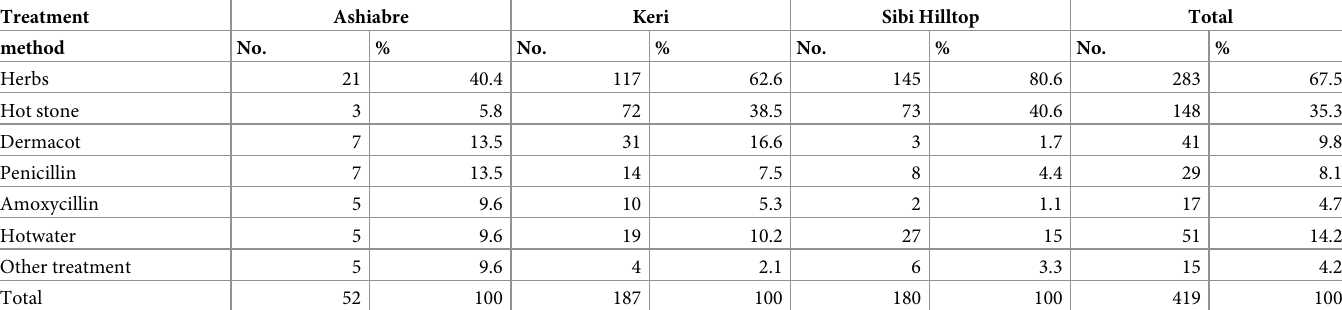
Table 4. Summary of ulcer treatment methods reported by study